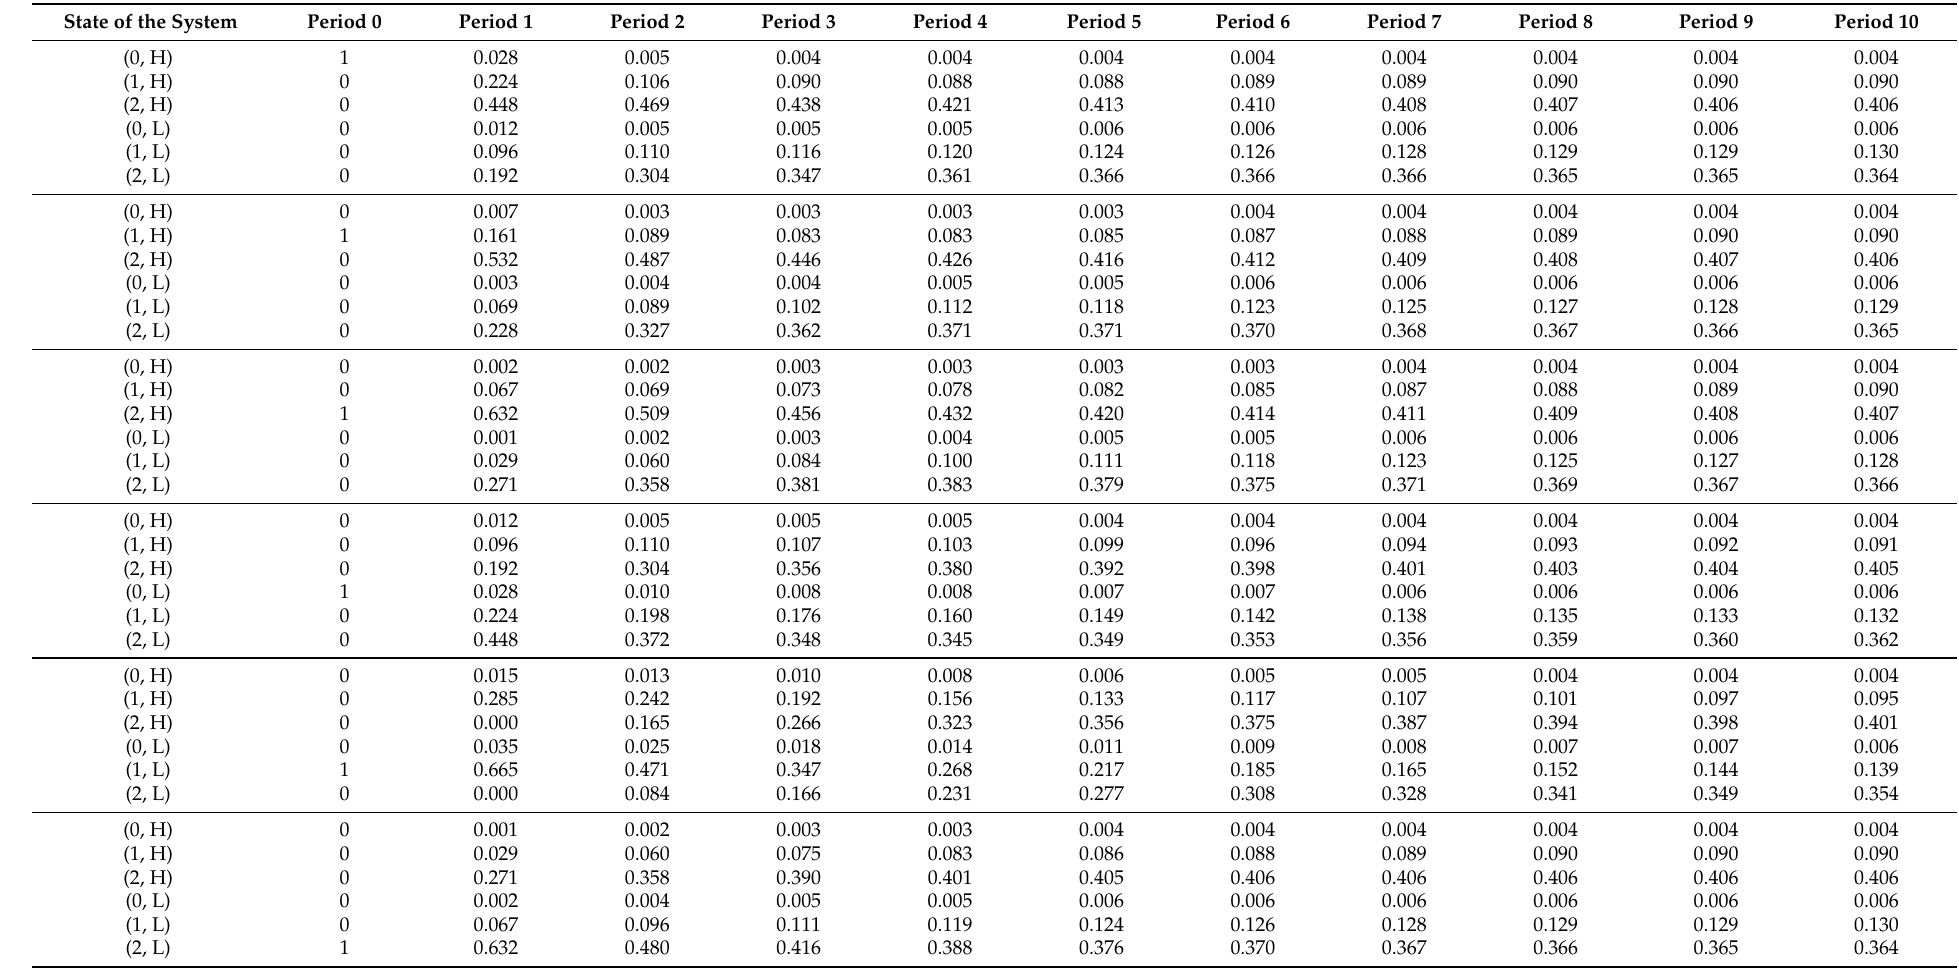
Table 14. Transition probabilities with different initial states for the system with two active firms in the Cournot